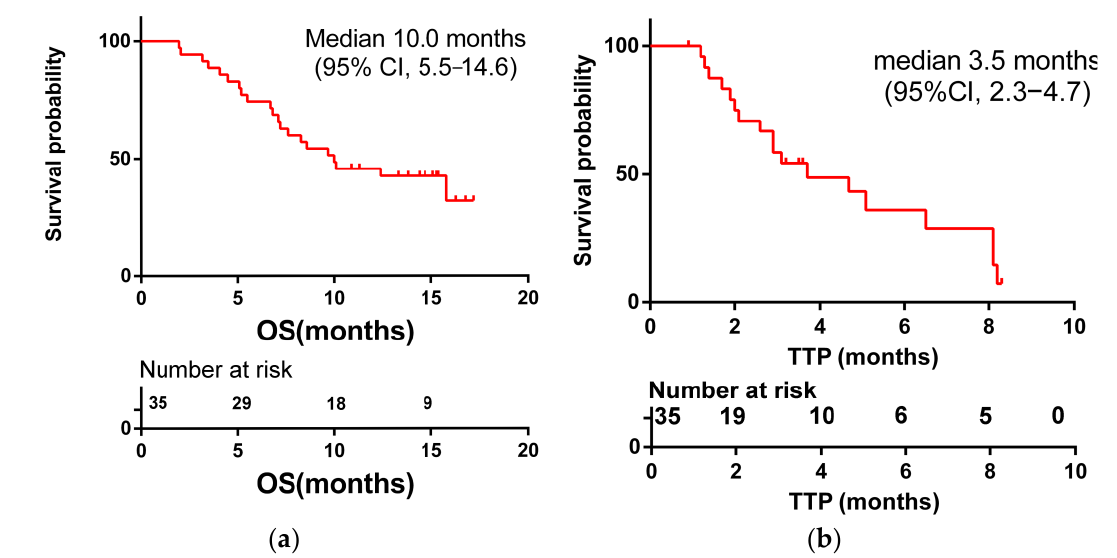
Figure 1. Kaplan – Meier curves for overall survival (OS) ( a ) and time to progression (TTP) ( b ) in 35 patients undergoing HAIC with oxaliplatin plus raltitrexed (HAICROX).